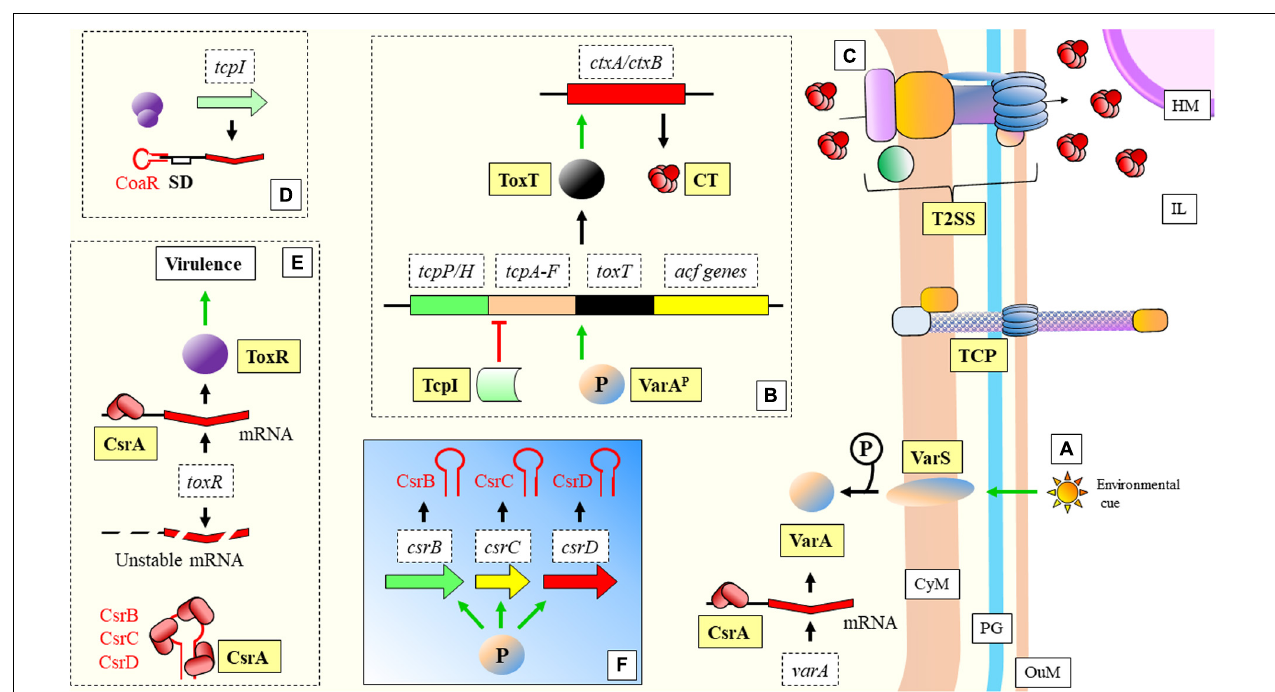
FIGURE 7 | Vibrio cholerae : mechanisms of virulence and regulation. (A) Environmental cues trigger the signalization in the two-component system VarS/VarA (functional homologs to the GacS/GacA two-component system of P. aeruginosa ). Phosporilation of VarA activates this protein. Transcription of varA is facilitaded by CsrA. (B) VarA P (activated) acts as a transcriptional activator of toxT . ToxT activates as well ctxA/ctxB encoding the two subunits of the CT protein, which is extruded to the IL through a T2SS (C) . The tcpA gene, required for the assembly of the TCP, is located in the same operon as toxT . TcpI is a transcriptional inhibitor of tcpA . TCP structure is necessary for the progression of the disease (bacterial aggregation and microcolony formation). (D) CoaR sRNA blocks binding of the ribosome to the tcpI mRNA. (E) CsrA stabilizes toxR mRNA, which is necessary for positive regulation of virulence genes. (F) VarA P activates transcription of CsrB, CsrC, and CsrC sRNAs, which sequester CsrA, yielding an unstable toxR transcript. CT, Cholera toxin; CyM, Cytoplasmic membrane; HM, Host cell membrane; IL, Gastrointestinal lumen; OuM, Outer membrane; PG, peptidoglycan; T2SS, Type II secretion system; TCP, Toxin coregulated pilus. Black thick arrows indicate flow of a biological process, e.g., protein translation. Green thick arrows indicate activation. Red thick arrows with flat cap indicate inhibition. References: Hammer and Bassler, 2007; Jang et al., 2011; Cobaxin et al., 2014; Mey et al., 2015; Ng et al., 2016; Dorman and Dorman, 2018; Jemielita et al., 2018; Butz et al., 2019; Xi et al.,